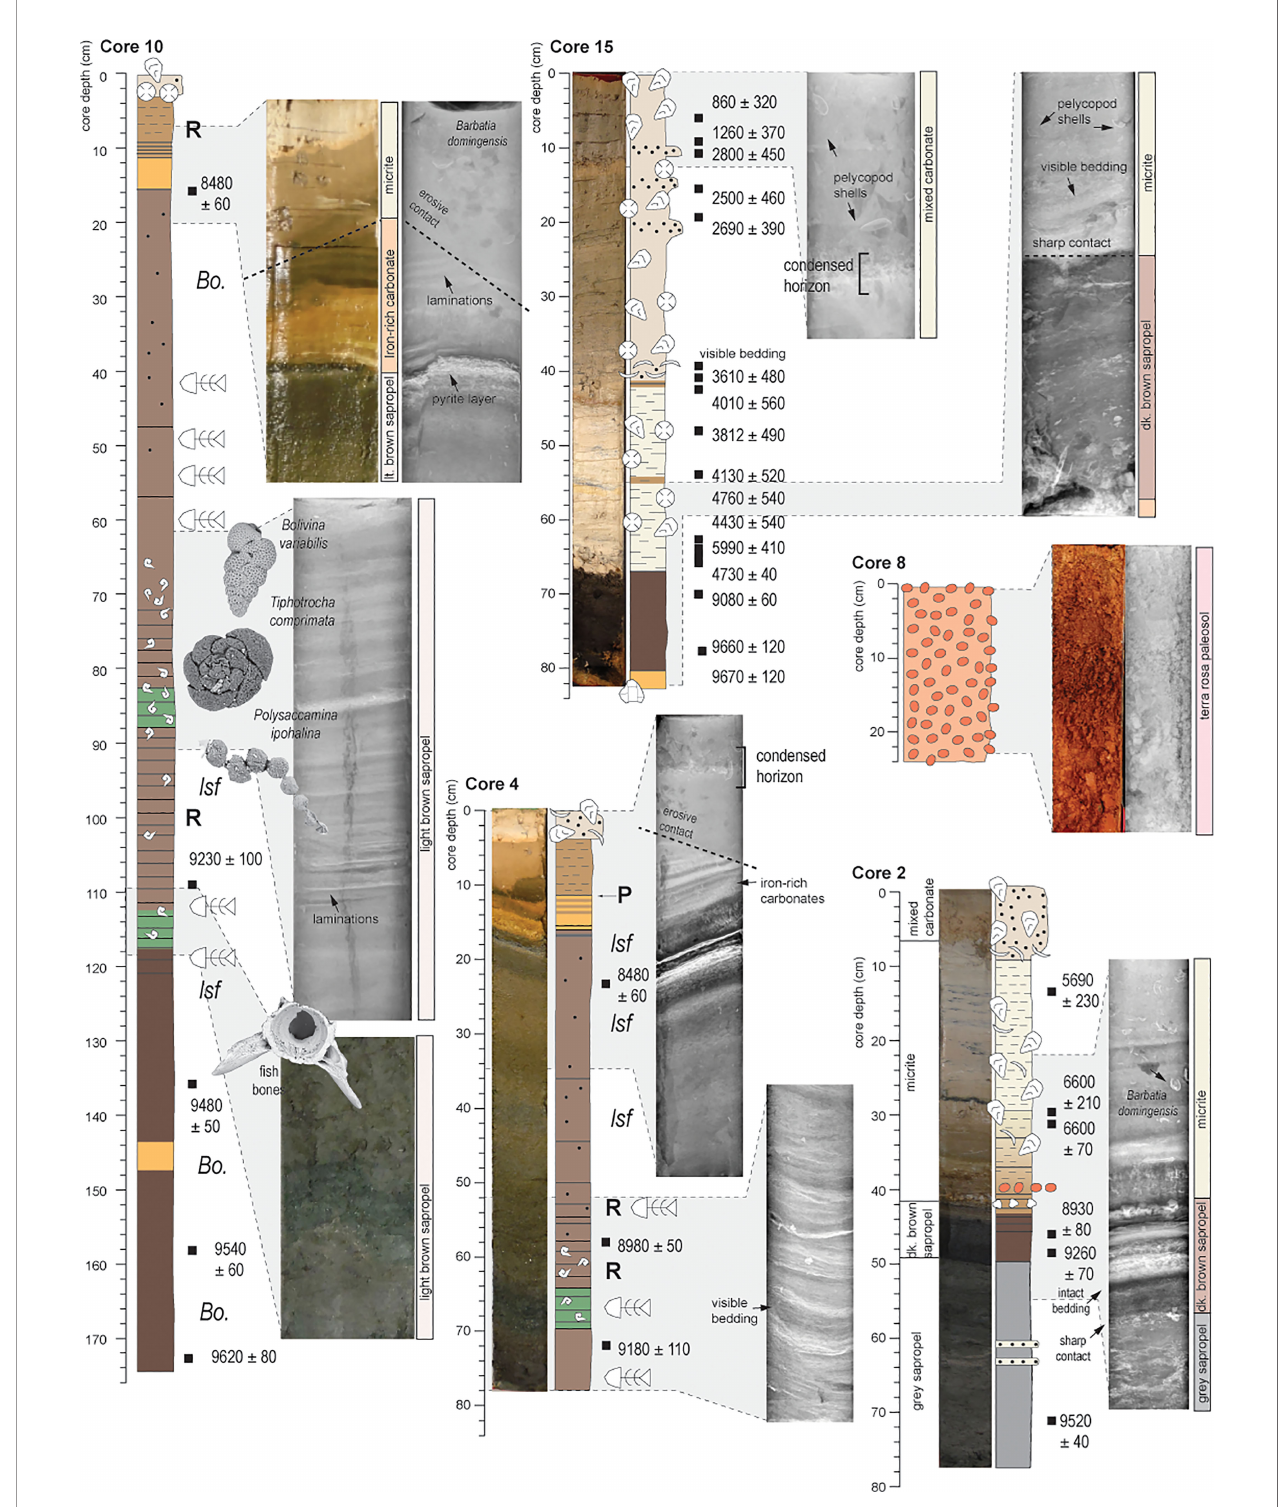
FIGURE 6 | Representative photographs, radiographs, and scanning electron micrographs from key sedimentary units and transitions, along with the cores logs (and symbols) from Figure 3 . Sediment radiographs document distinct laminations and bedding from negligible vertical sediment mixing, and clear stratigraphic contacts.